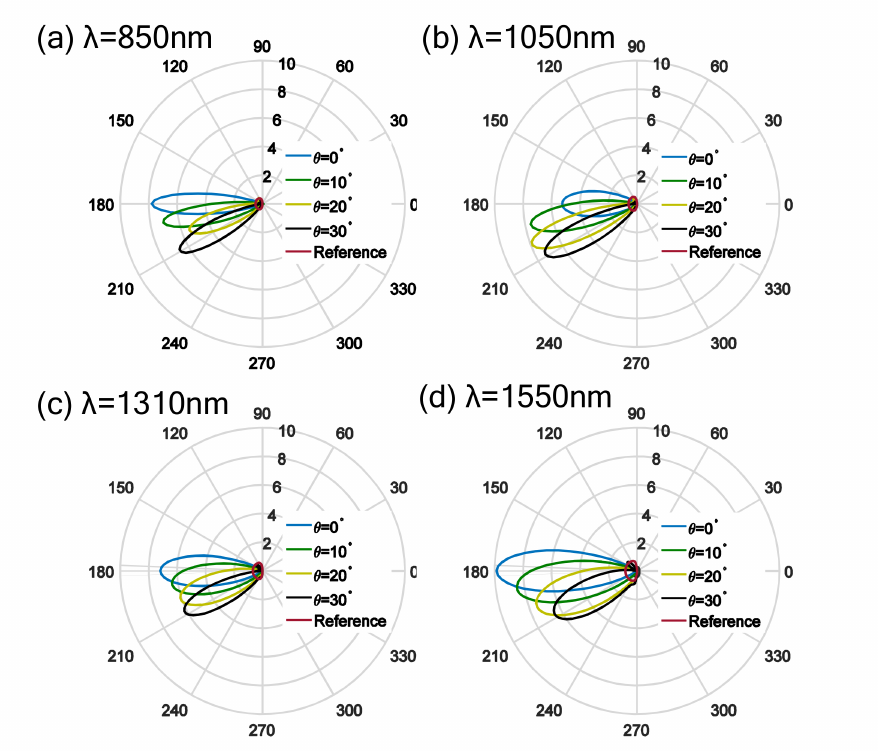
Figure A7. Polar diagrams of the nanoantennas inversely designed as shown in Figure A4.